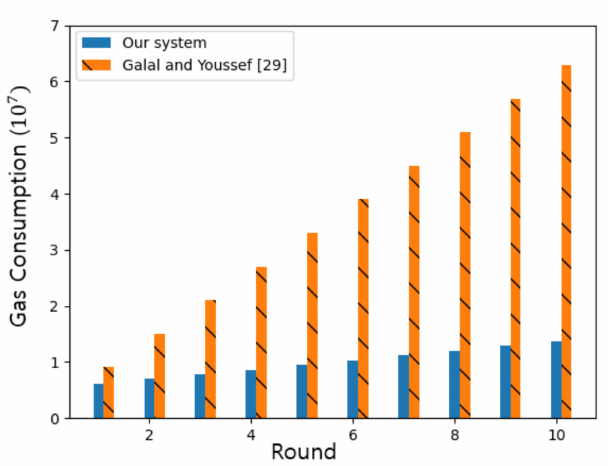
Figure 16. Progressive gas consumption of our system compared against Galal and Youssef [29].